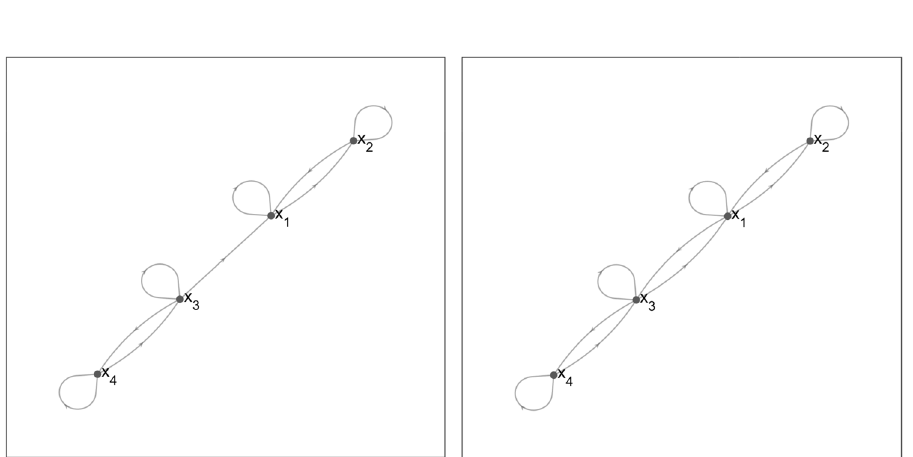
Figure 5. Directed graph of the Pharmacokinetics model ( M 5 ). (Left) For the scenario x 3 ( 0 ) = x 4 ( 0 ) = 0 . The model is divided into 2 strongly connected components. (Right) For the scenario x 3 ( 0 ) = 0 and x 4 ( 0 ) = 0 . The additional connection between nodes x 1 and x 3 reduces the model down to a single component. The result is that a greater amount of information is transferred between the individual model